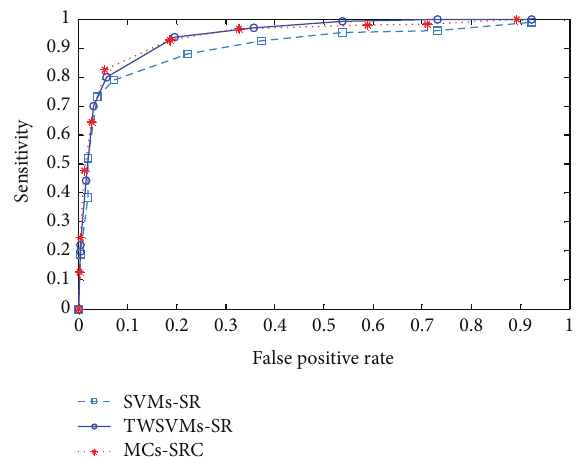
Figure 3: Comparisons of ROC curves of MCs detection and classification using the proposed methods.